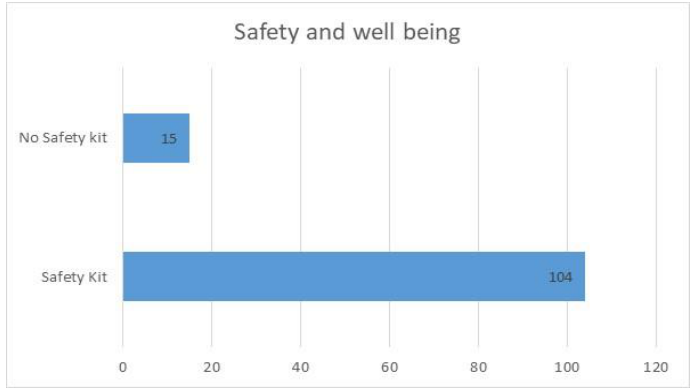
Figure 1. Safety and wellbeing of waste pickers. Source: Computed by authors. Table 1. Safety and wellbeing of waste pickers.